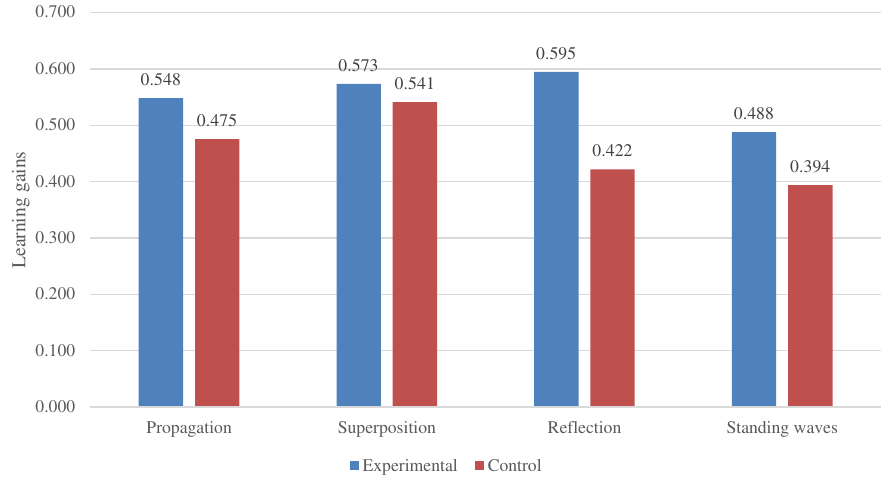
FIG. 4. Normalized learning gains across main topics in mechanical